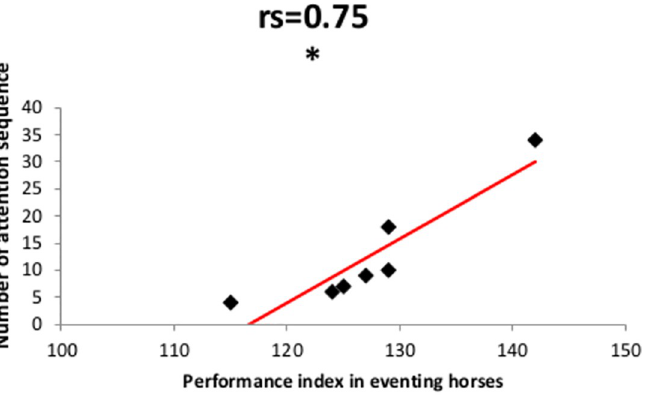
Fig 4. Correlation between the performance index i . e ., individual score of performance in competition since the beginning of each horse’s career, for eventing horses and the number of overall attention sequences towards the visual stimulus during the 5 min of the VAT test, Spearman’s rank correlation test, N = 7, � P < 0.05.